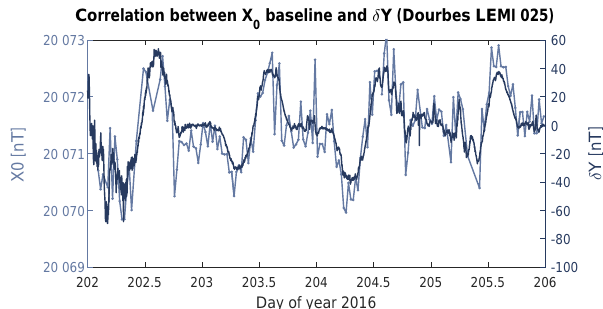
Figure 2. Light blue: X 0 baseline computed from high-frequency absolute measurements. Dark blue: variometer Y component from the LEMI-025. Because the variometer is not properly oriented, a strong correlation appears between X 0 and Y